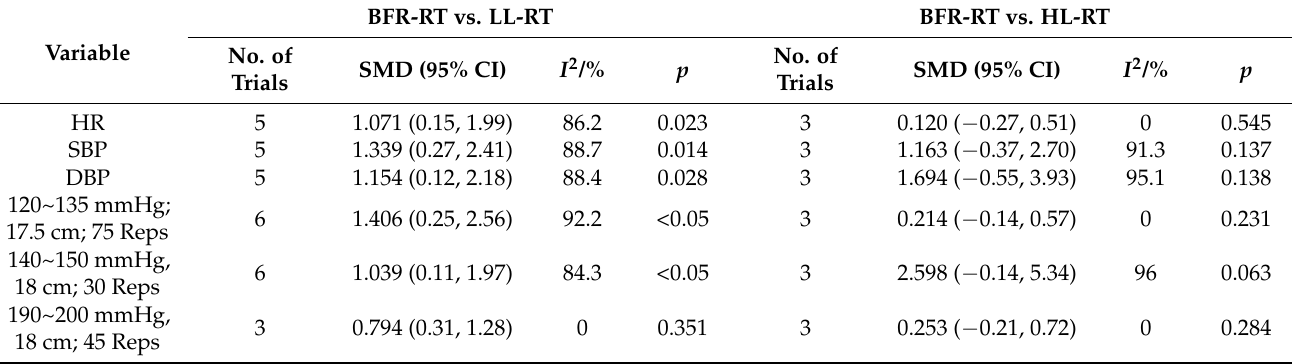
Table 3. Subgroup analysis results of regulatory variables for acute cardiovascular response